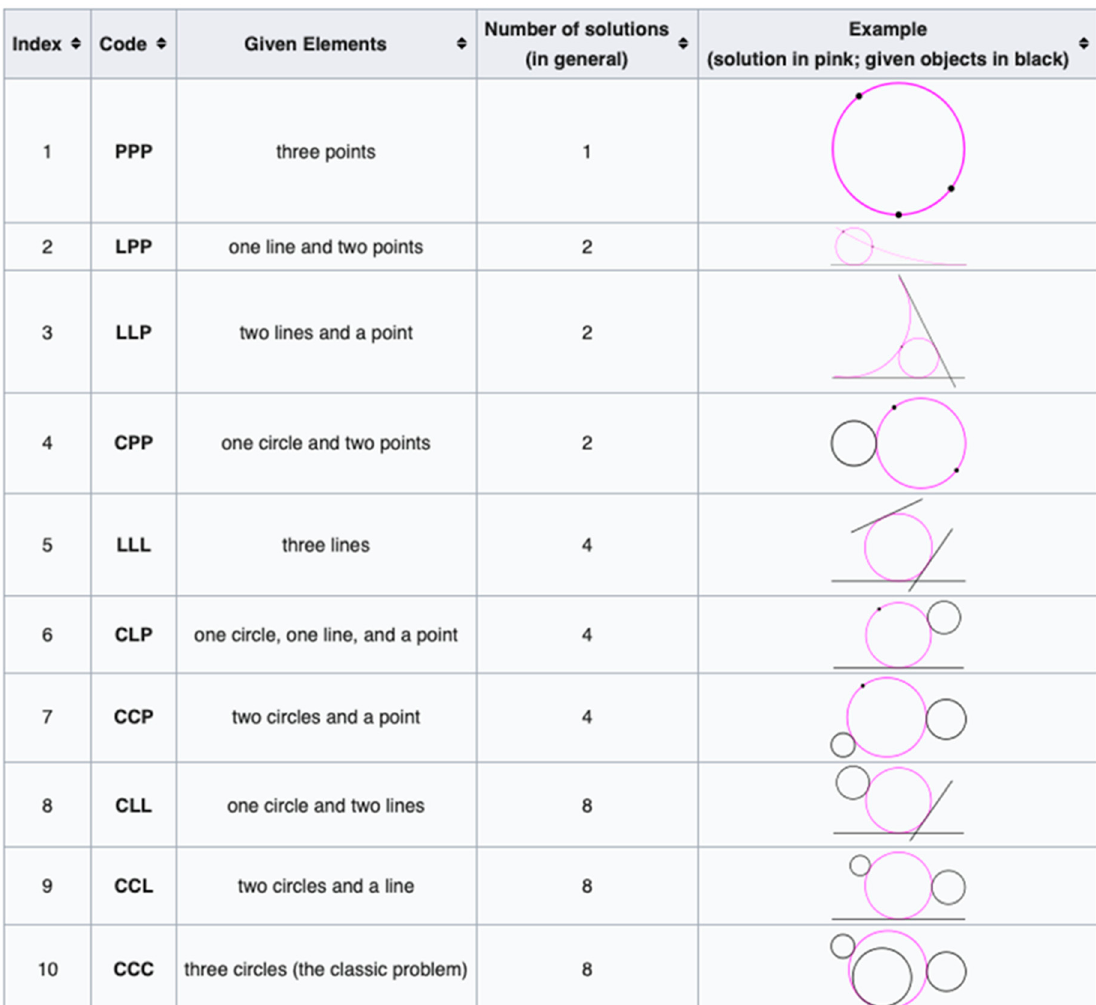
Figure 1. Ten cases of Apollonius’ problem (P-point, L-line,